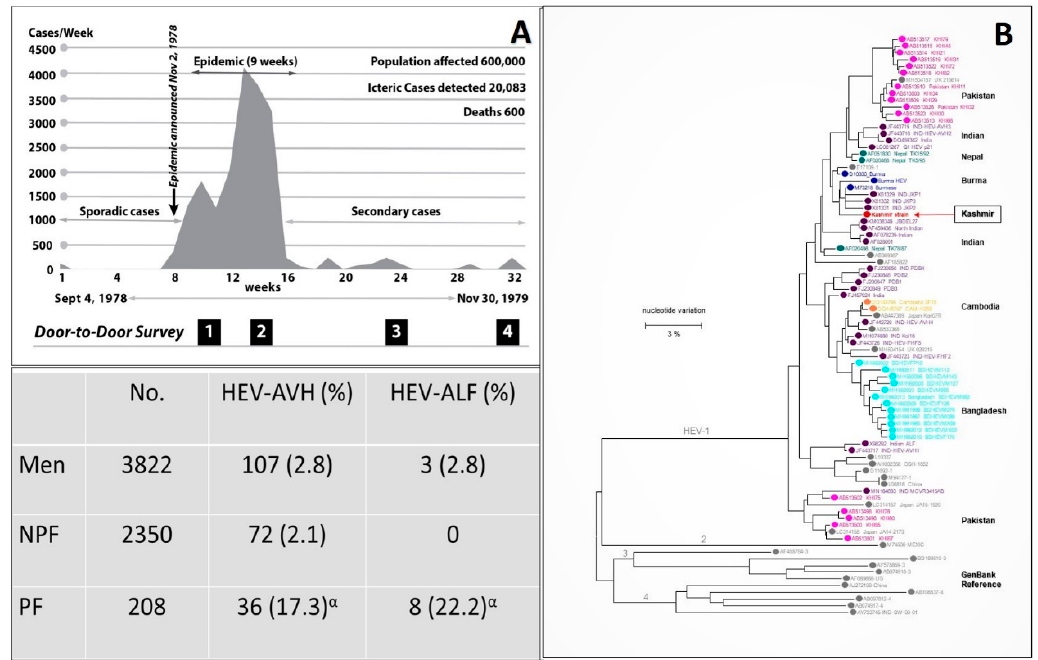
Figure 1. Gulmarg Kashmir Epidemic, 1978–1979. ( A ) Upper panel. The epidemic curve with the weekly occurrence of hepatitis E cases. The region had an open-source water supply from a canal (Ningli Nallah) which originates from the Alpather Lake situated at the foot of Apharwat Peaks, Gulmarg. After passing through mountains as the world-famous Sharanz waterfall, the stream crosses the valley to join the Wular lake. The canal along its route is used for multiple purposes including drinking water, linen washing, swimming, fishing, and sewage and garbage disposal, and thus stays highly polluted. Lower panel. The data on incidence and severity of viral hepatitis in men (15–45 years), NPF (nonpregnant females; 15–45 years) and PF (pregnant females) were collected by four door-to-door surveys done at 4 to 6 week intervals during the epidemic. ( B ) Kashmir strain of HEV (Pinglina epidemic, 1993–94, Kashmir, India [20].). Unrooted phylogenetic tree generated by Maximum Likelihood method using MEGA software (version 10.1.8), on the basis of 326 bp sequences of HEV ORF1 genomic. Reference sequences of different HEV genotypes from GenBank are shown in gray filled circles, while country specific HEV sequences are shown in color filled circles. Kashmir strain of HEV was of genotype 1 with 94.6% homology with the Burmese isolates of HEV (Courtesy Saleem Kamili & Xia, Guo-Liang, both at CDC, Atlanta, Georgia). α = 6 pregnant women